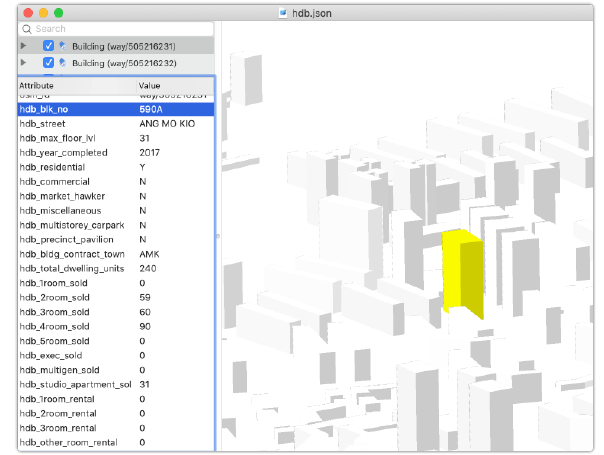
Figure 10. Viewing the generated CityJSON dataset in azul (Ar- royo Ohori, 2020), indicating the rich attribute set for each build- ing, e.g. number of apartments and their